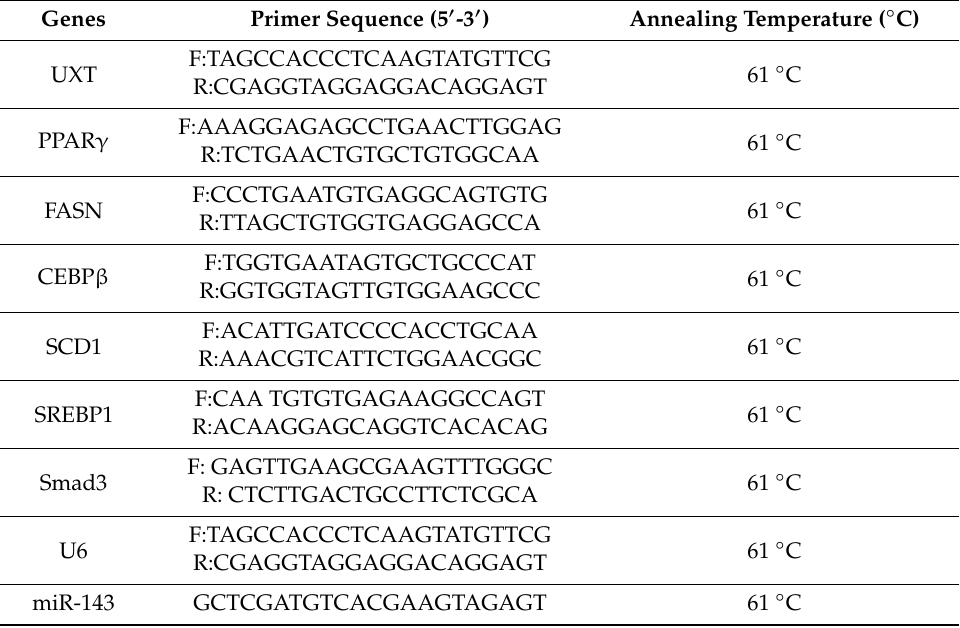
Table 1. Sequence of primers for mRNA and miRNA quantitative real-time PCR. Genes Primer Sequence (5 (cid:48) -3 (cid:48) ) Annealing Temperature ( ◦